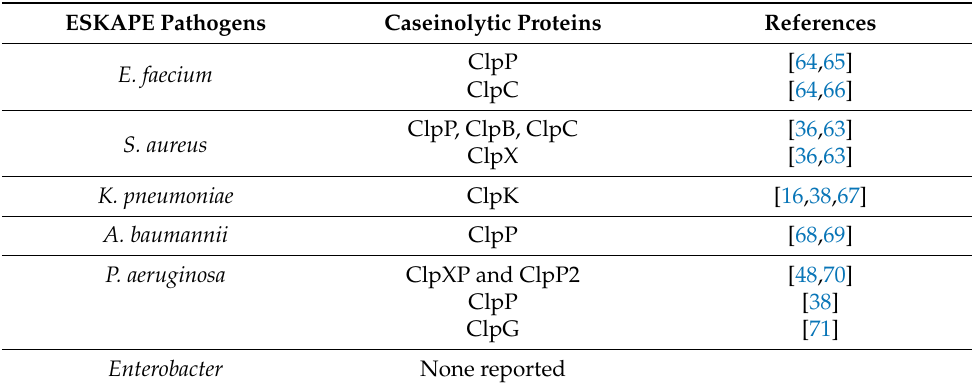
Figure 4. Two Clp ATPase subfamilies. A tagged protein is recognised by a Clp ATPase. ( a ) Members of the ClpB/Hsp104 subfamily lack the tripeptide for ClpP interaction and function along with the DnaK system to unfold and refold the protein into its functional conformation. ( b ) Members of the ClpA subfamily contain the tripeptide for ClpP interaction and therefore redirect proteins which cannot be unfolded and reactivated to ClpP for degradation. Adapted from Maurizi and Xia [61]. Table 3. Caseinolytic proteins identified in ESKAPE